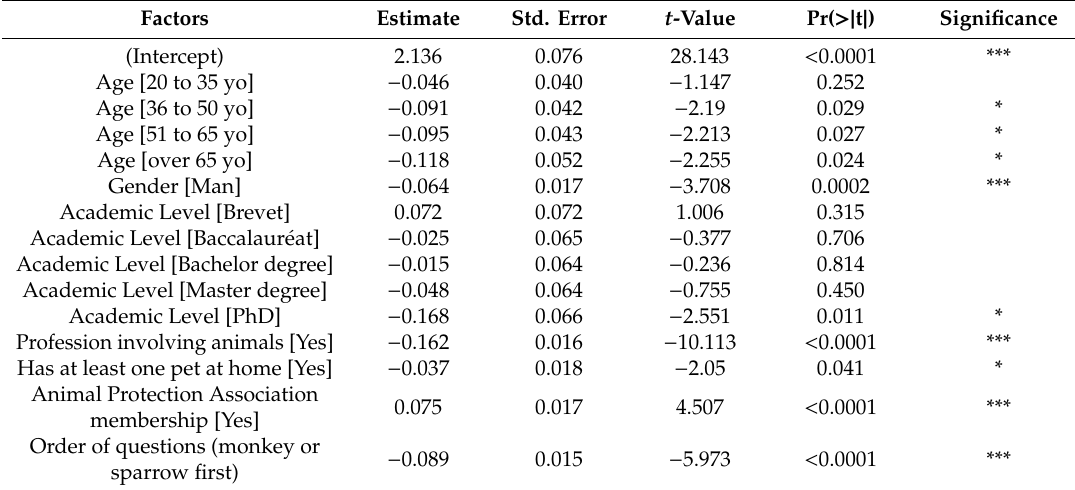
Table 1. Statistical values for the GLzM with the Anthropomorphism Score as response variable. For Age, indicated factors are compared with Age [under 20 yo]. For Gender, ‘man’ is compared to ‘woman’. For academic levels, factors are compared to [Without diploma]. For the remaining questions [Yes] is compared to [No]. For the estimate and the t -value, a positive value indicates a positive influence of the factor; a negative value indicates a negative influence. Significance: * < 0.05, ** < 0.01, *** < 0.001.